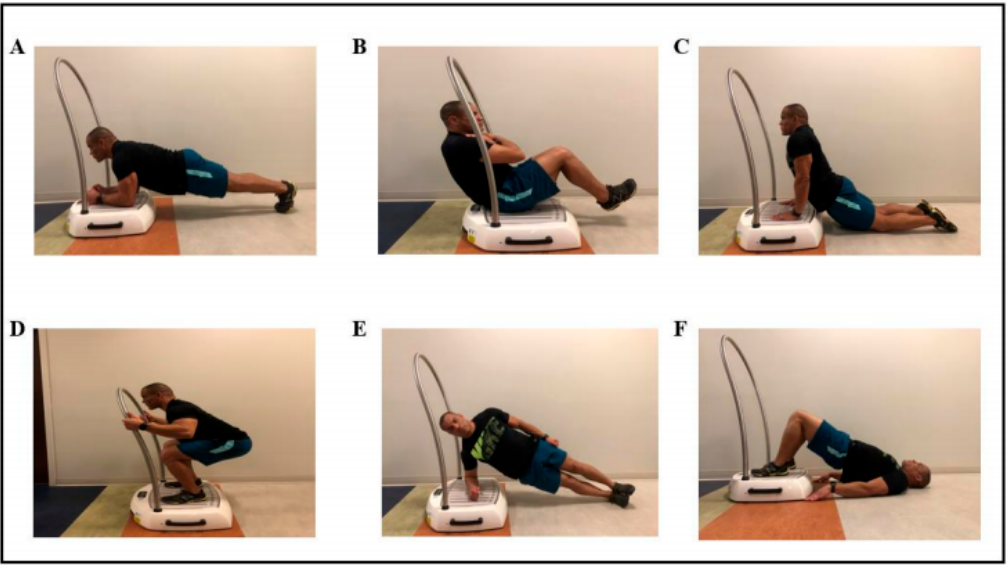
Figure 1. Core exercise training program. ( A ) Plank, ( B ) V-up, ( C ) Back extension, ( D ) Squat, ( E ) Side-plank, ( F ) Bridge.